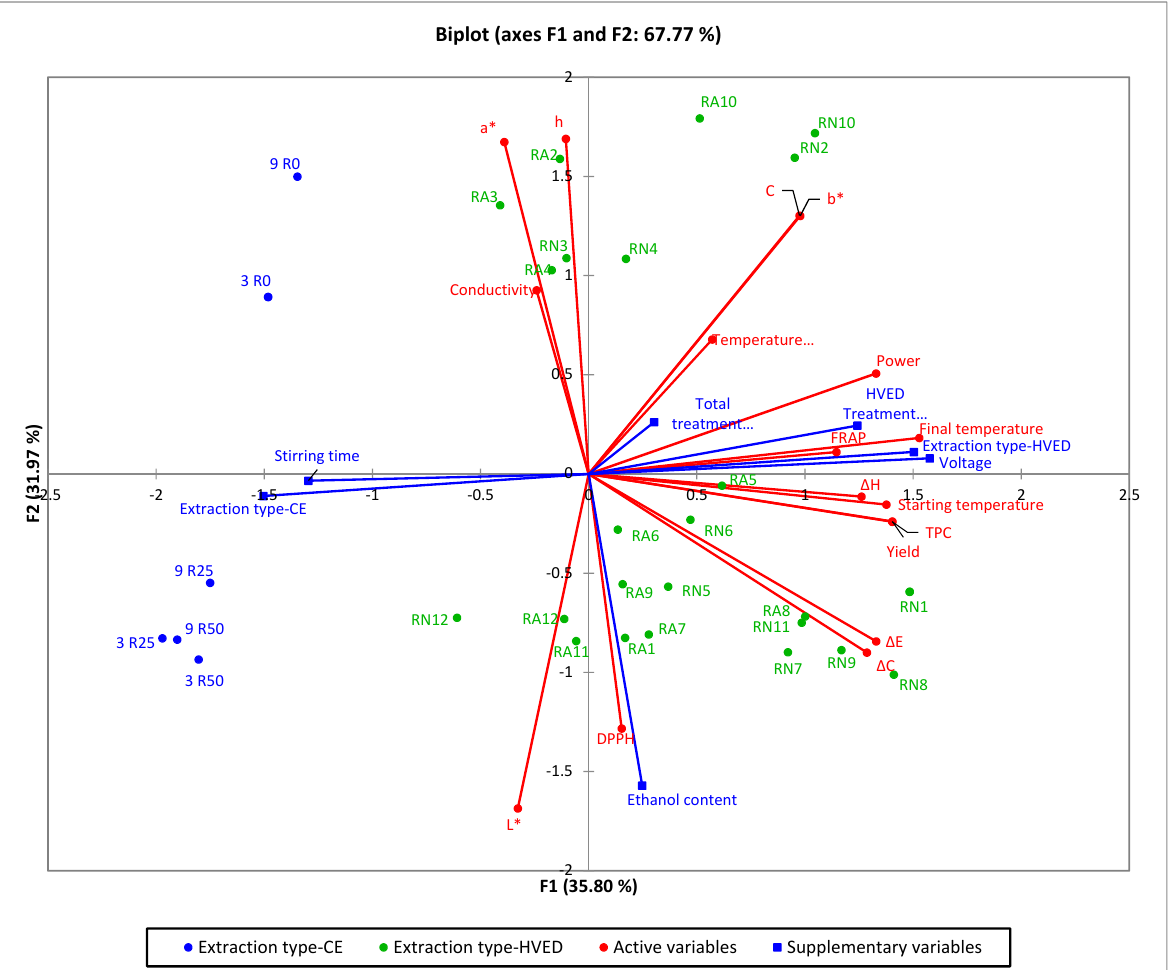
Figure 6. Biplot of the principal component analysis applied on all samples including the active variables (physical parameters, phenols and antioxidants, and parameters of color) and parameters of the experiment design as supplementary variables.